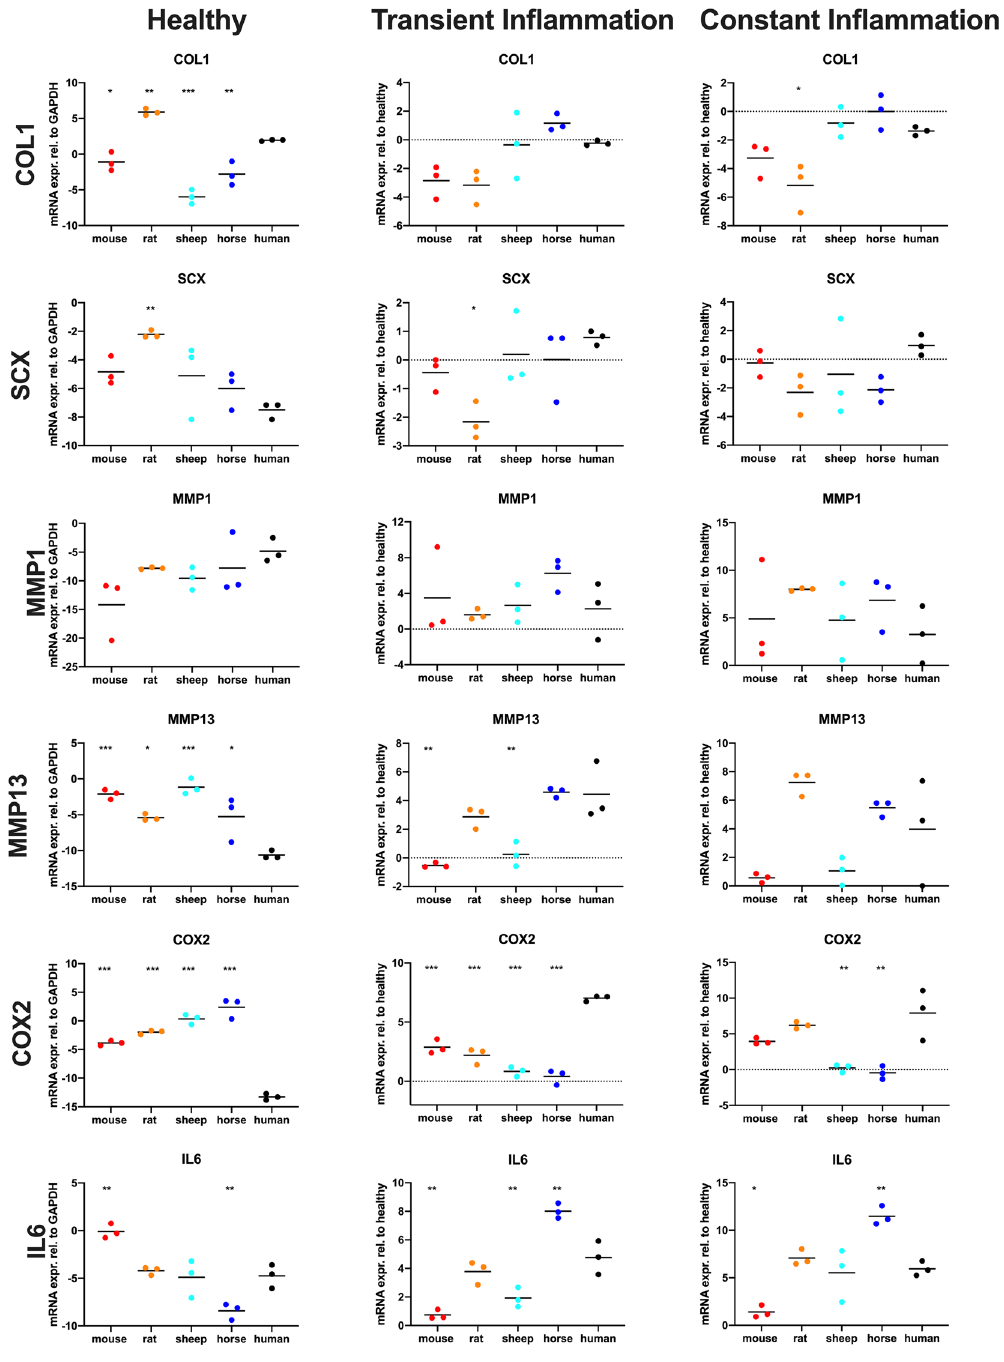
Figure 4. Scatter dot plots showing COL1, SCX, MMP1, MMP13, COX2 and IL6 gene expression (presented as log2) of healthy tenocytes and tenocytes exposed to inflammatory stimuli for 24 h (transient inflammation) or continuously (constant inflammation) in different species (the black lines indicate the respective means). Gene expression in the inflammatory conditions is shown relative to the healthy tenocytes. Each dot represents a different biological replicate. Differences were evaluated using ANOVA with Tukey HSD test, * p < 0.05; ** p < 0.01; *** p <